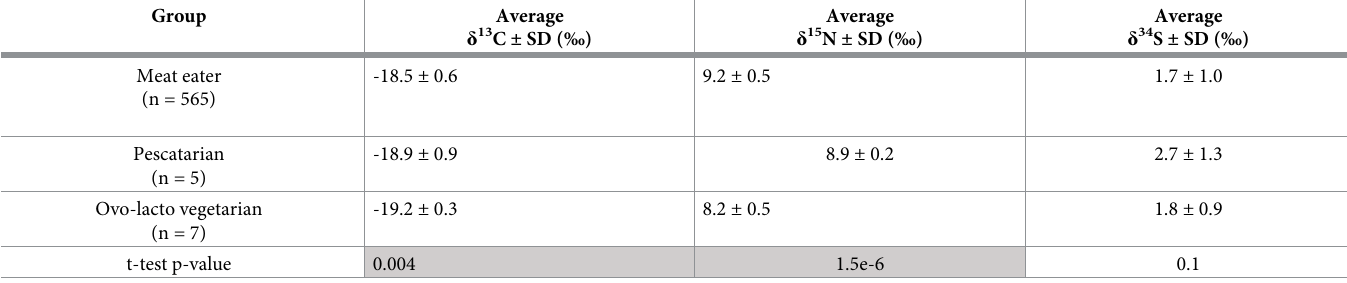
Table 4. δ 13 C hair , δ 15 N hair and δ 34 S hair values relative to meat consumption. p-values from t-tests comparing δ 13 C hair , δ 15 N hair and δ 34 S hair values between omnivores vs. pescatarians and ovo-lacto vegetarians. Pescatarians and ovo-lacto vegetarians were combined for the t-test because of the limited number of participants reporting this diet